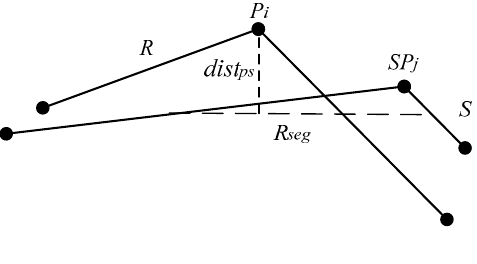
Figure 5. Point-segment distance.